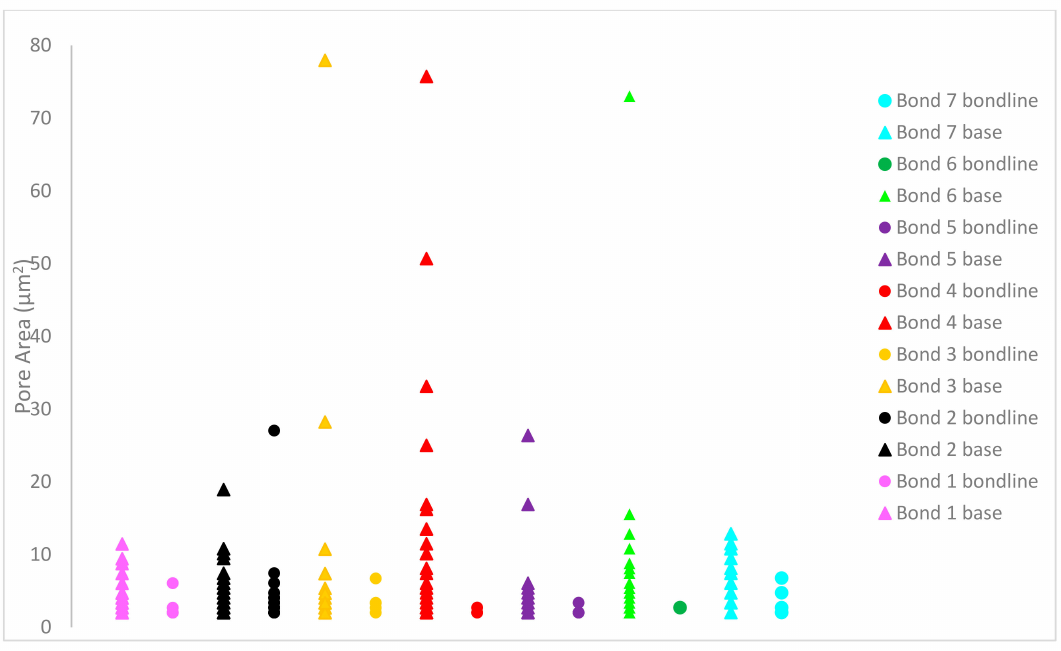
Figure 11. Pore-size